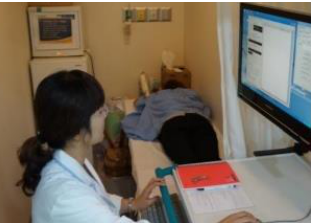
Figure 14. Clinical trial view of an MT test system developed by Jeon et al. [70]. Reprinted with permission from [70].